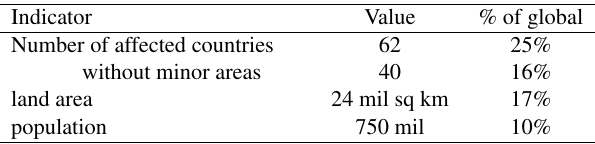
Table 1. Effects of transformation events on global indicators